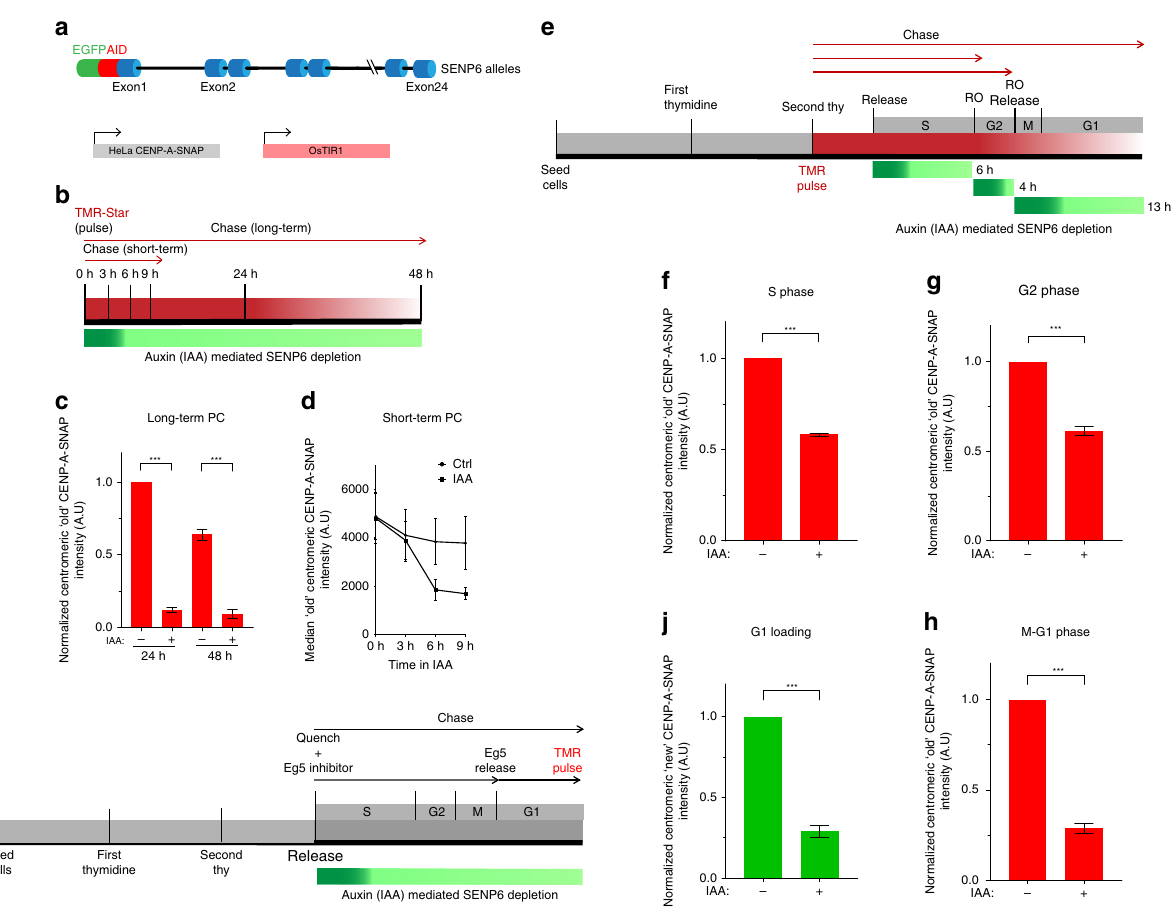
Fig. 3 SENP6 is required for centromeric CENP-A maintenance throughout the cell cycle. a Schematic of the genotype of cell line constructed for auxin (IAA)-mediated depletion of SENP6. OsTIR1 and CENP-A-SNAP are expressed as transgenes, SENP6 is homozygously tagged at its endogenous locus. b Experimental scheme for long-term and short-term CENP-A-SNAP pulse-chase (PC) assays following auxin (IAA) mediated depletion of SENP6. c , d Quanti fi cation of long-term and short-term PC experiments, respectively following the experimental scheme detailed in b . c ‘ Old ’ centromeric CENP-A- SNAP intensities are normalized to the mean of the non-treated condition ( − ) for the 24 h time point and plotted as bar graphs against auxin (IAA) treated ( + ) and non-treated ( − ) conditions for 24 h and 48 h. Three replicate experiments were performed. Bar indicates SEM. Parametric two-tailed Student ’ s t test were performed to calculate statistical signi fi cance. *** p < 0.001 d ‘ Old ’ centromeric CENP-A-SNAP intensities are measured and median intensities are plotted against auxin (IAA) or non-treated (Ctrl) conditions. Bars indicate SEM of three replicate experiments. e Experimental scheme of cell cycle synchronization coupled to CENP-A-SNAP pulse-chase (TMR pulse) and auxin (IAA) mediated depletion of SENP6 at different stages of the cell cycle (RO: RO3306, Cdk1 inhibitor). f – h Quanti fi cation as in c but normalized to non-treated condition ( − ) of ‘ old ’ CENP-A-SNAP intensities after auxin (IAA) mediated depletion of SENP6 at different stages of the cell cycle following the experimental scheme of e . i Experimental scheme of cell cycle synchronization in G1 phase coupled to CENP-A-SNAP quench-chase-pulse and auxin (IAA) mediated depletion of SENP6. EG5 inhibitor Dimethylenastron was used for a mitotic arrest followed by release into G1. j Quanti fi cation as in f – h of ‘ new ’ CENP-A-SNAP intensities in G1 stage of the cell cycle after auxin (IAA) mediated depletion of SENP6 following the experimental scheme in i . Source data are provided as a Source Data fi